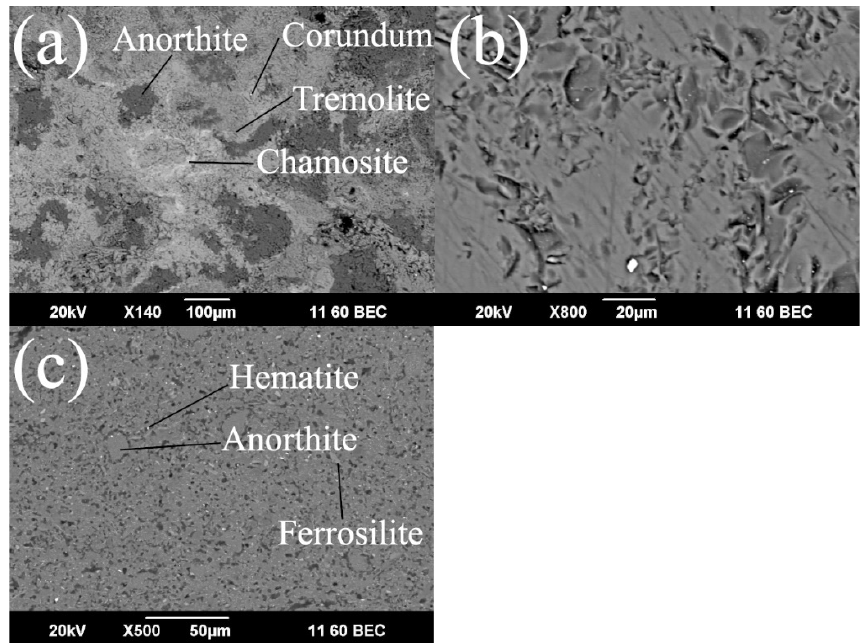
Figure 2. SEM images of ( a ) natural basalt ore; ( b ) basalt glass ceramics; ( c ) sintered basalt